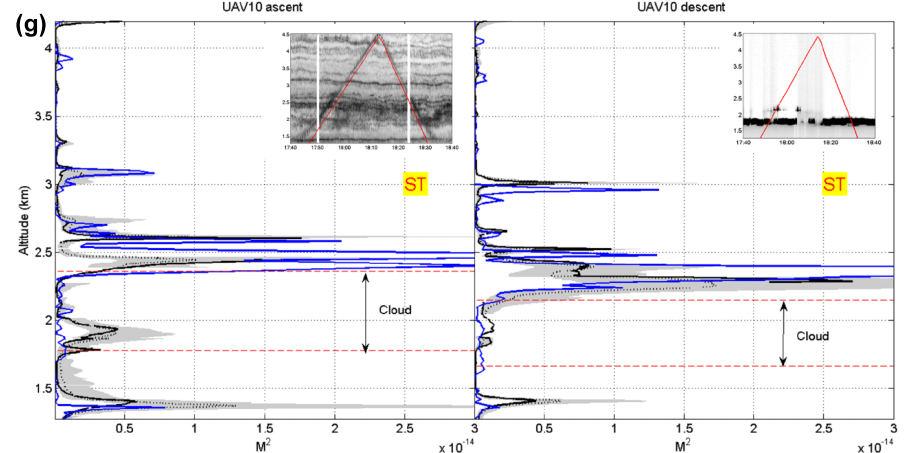
Figure 5. (a) M 2 (blue) and M 2 (solid black: 1min averaged; dotted black: 4min averaged) profiles for flight UAV4. The thin black UAV radar line is from radar data during the flight, and the bold black line is from radar data collected 7min before. Gray color shows the standard deviation over 4min. The lower red dashed line shows the top of the CL region and the higher one the interface between the KH and ST regions. (b) Same as (a) (without the thin black line) but for UAV5. (c) Same as (b) but for UAV6. (d) Same as (b) but for UAV7. (e) Same as (b) but for UAV8. (f) Same as (b) but for UAV9. (g) Same as (b) but for UAV10.